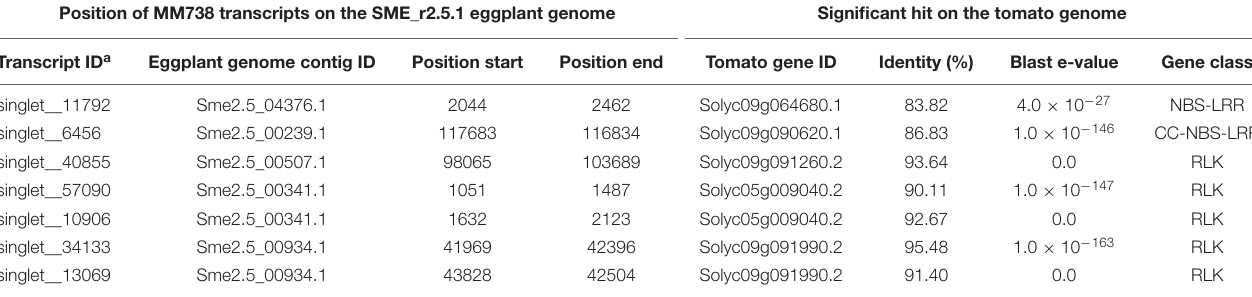
TABLE 7 | List of putative candidate genes for resistance to bacterial wilt retrieved from the eggplant P1 (MM738) parental line transcriptome in the EBWR9 physical region and their positions on the eggplant genome. Position of MM738 transcripts on the SME_r2.5.1 eggplant